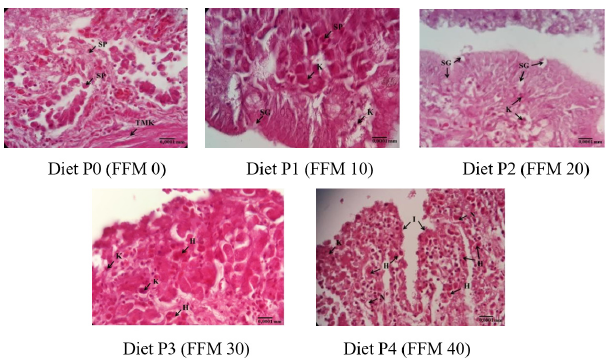
Figure 4. The intestinal histology of silver pompano fed with fermented feather meal. TMK = tunica muscularis, SP = leftover feed, SG = goblet cells (mucous cells), K = congestion, H = hemorrhage, I = irritation/erosion, N = necrosis coloration, HE = Hematoxylin Eosin, enlargement